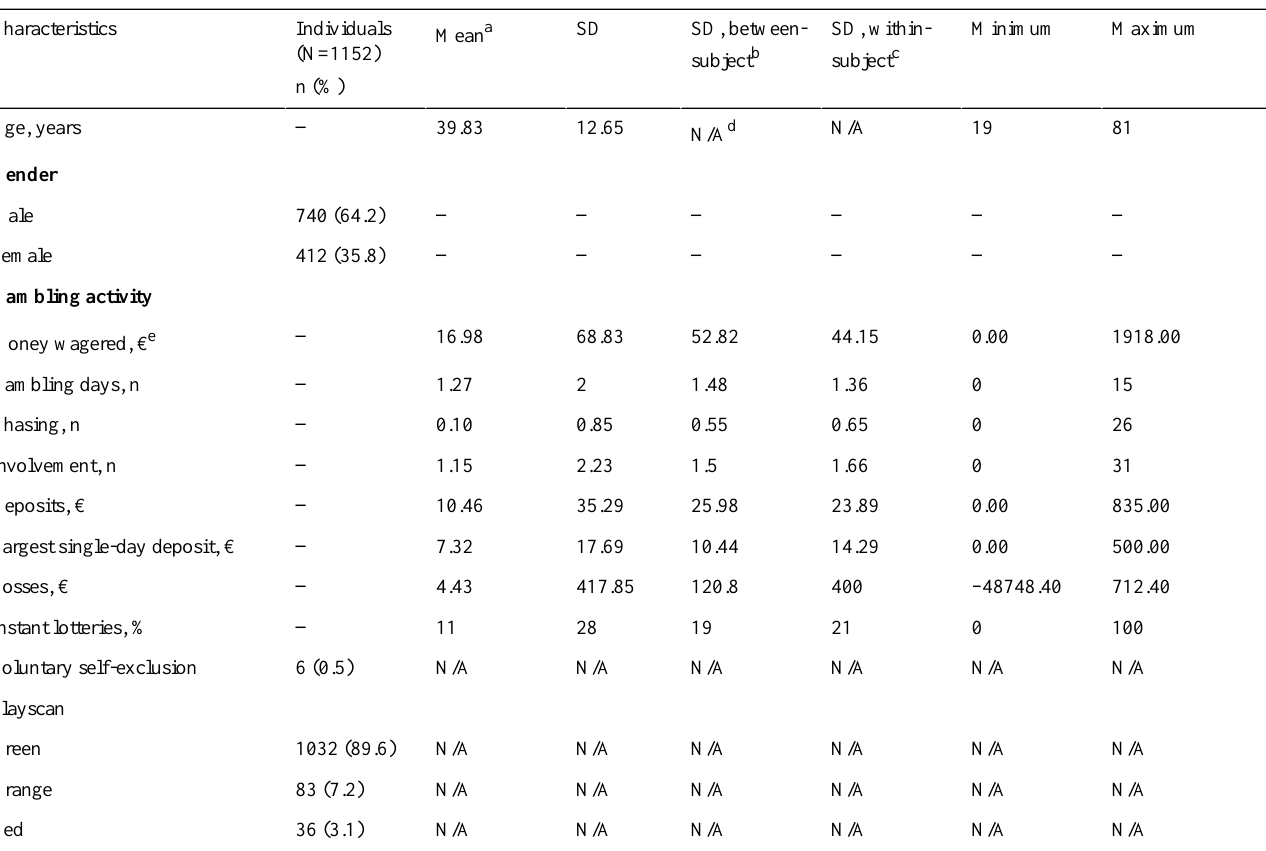
Table 1. Demographic and gambling characteristics of individuals who had newly registered for an online gambling account (over a period of 6 months).